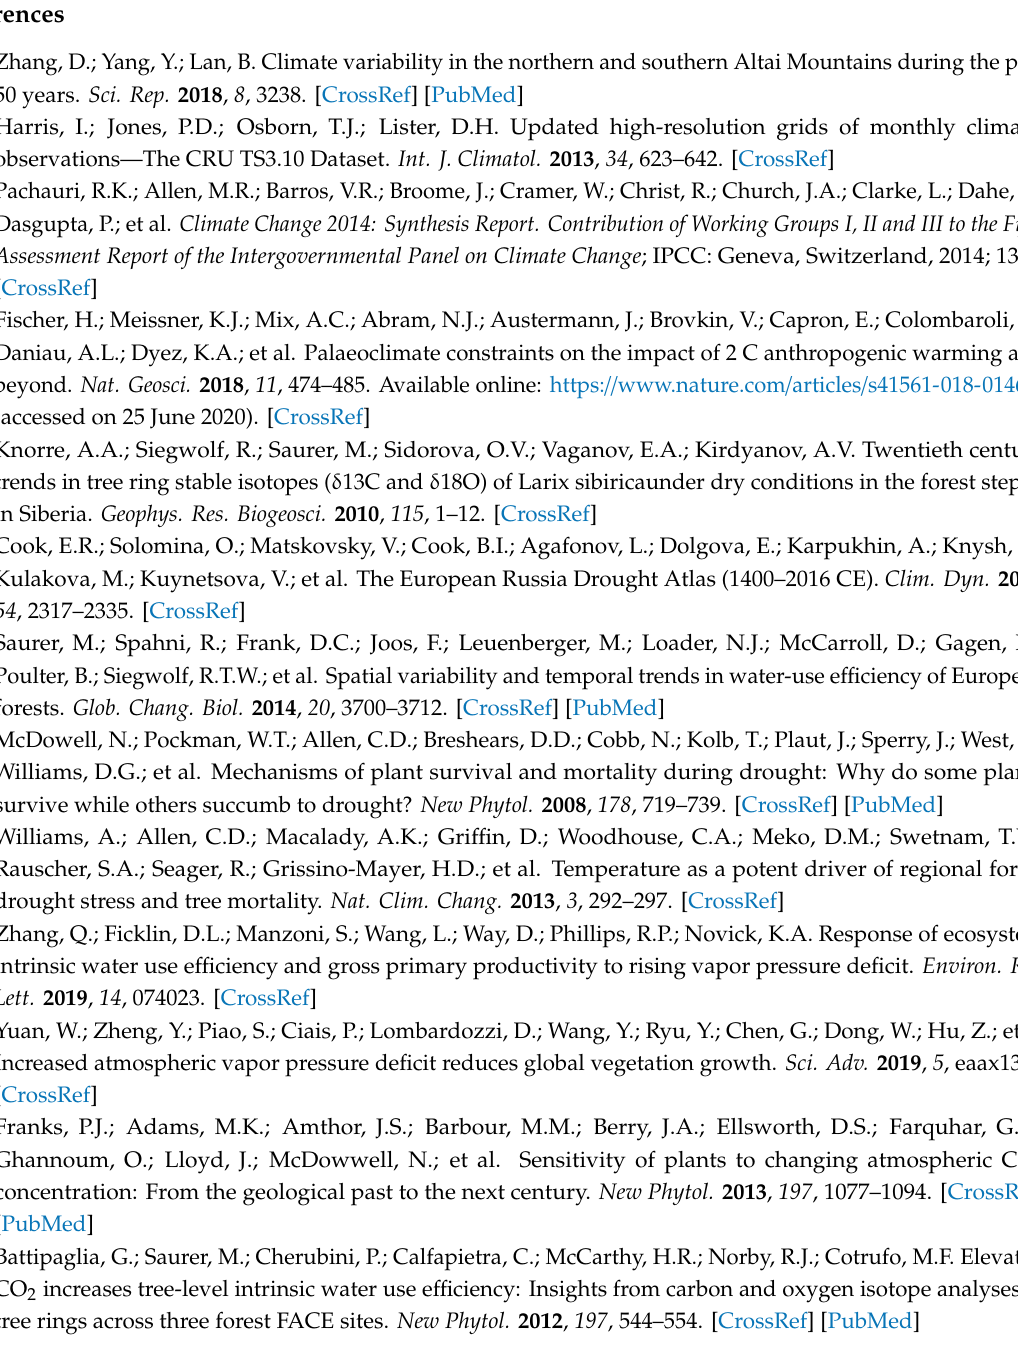
Figure S1: July air temperature (a) and July precipitation (b) data sets available from the local weather stations: Mugur-Aksi Mongun (MOG), Ak-kem for Koksu (KOK), Ersin for Ersin (HO) and Chadan for Chadan (CH) (see Table 1) study sites. A vertical red dotted line in 1985 indicates start of temperature and precipitation changes with the extremes during single years over the reference period